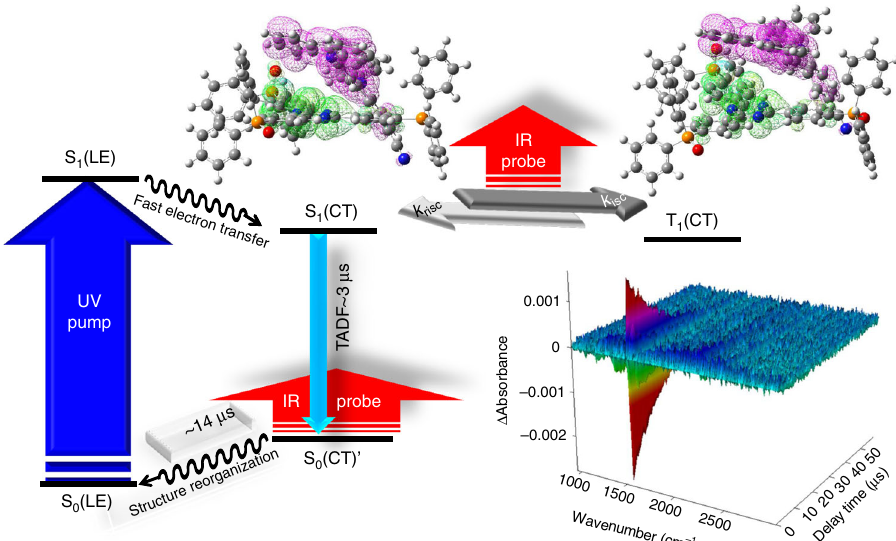
Fig. 3 The proposed TADF cycle. There illustrate the pump (266 nm)-probe (IR) Step-Scan FTIR experiment combined with the theorical calculation structure: the optimized CN-Cz2:PO-T2T exciplex structure in its S 1 and T 1 state, associated with HOMO (pink) and LUMO (green). The isovalue for the contours is 0.02. Note that the distance shown in double arrow bar (red) is estimated by the distance between two center planes. See text for detailed